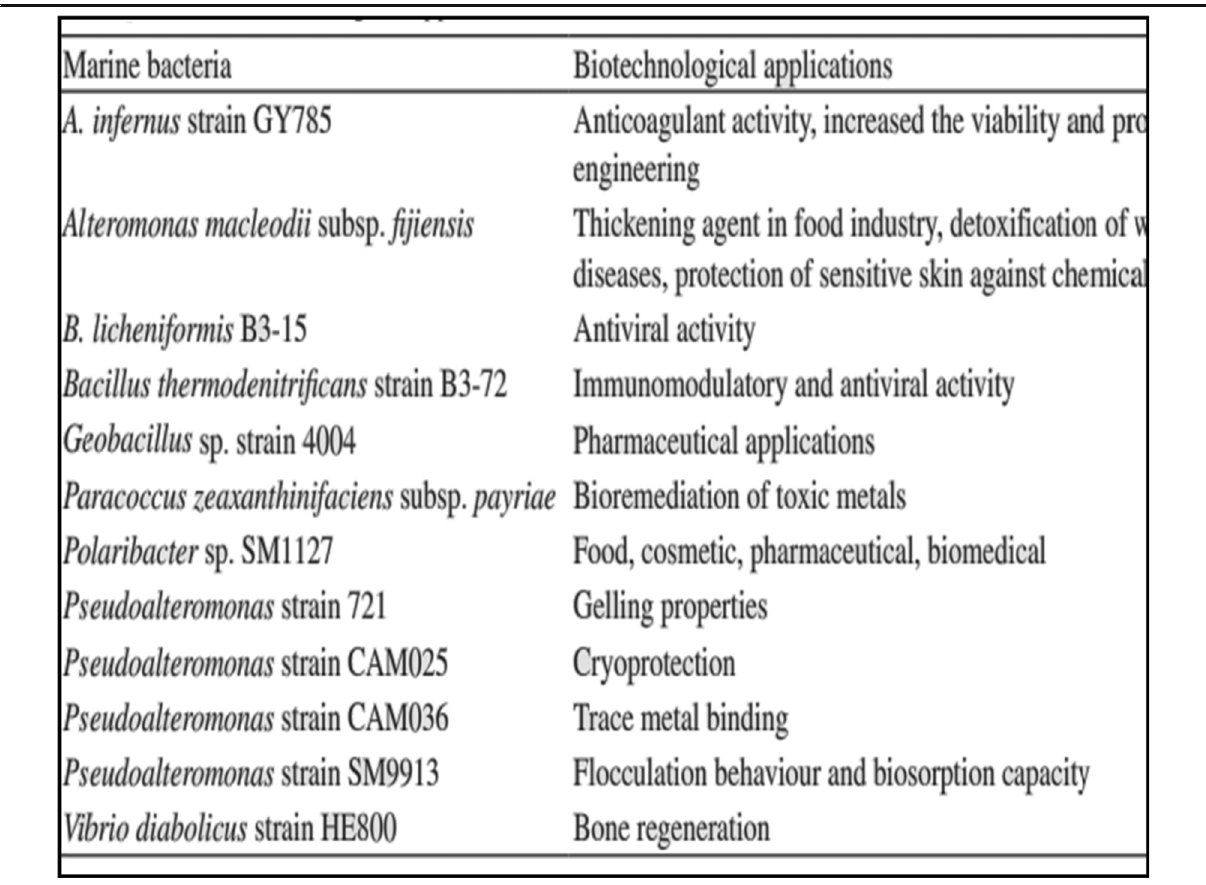
Table 4 Some potential biotechnological applications of marine bacterial